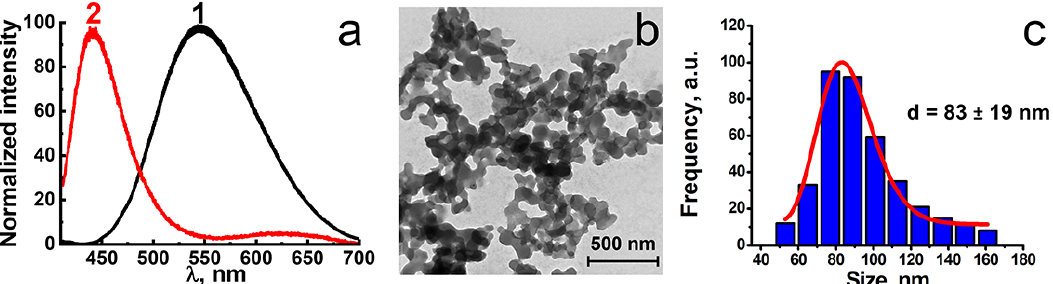
Figure 4. ( a ) Normalized intensity emission spectra of F-127-Cu 2 I 2 L 3 colloids (1) and DMF solution of Cu 4 I 4 L 2 complex (2). TEM image ( b ) and corresponding size distribution histogram ( c ) of dried F-127-Cu 2 I 2 L 3 colloids.